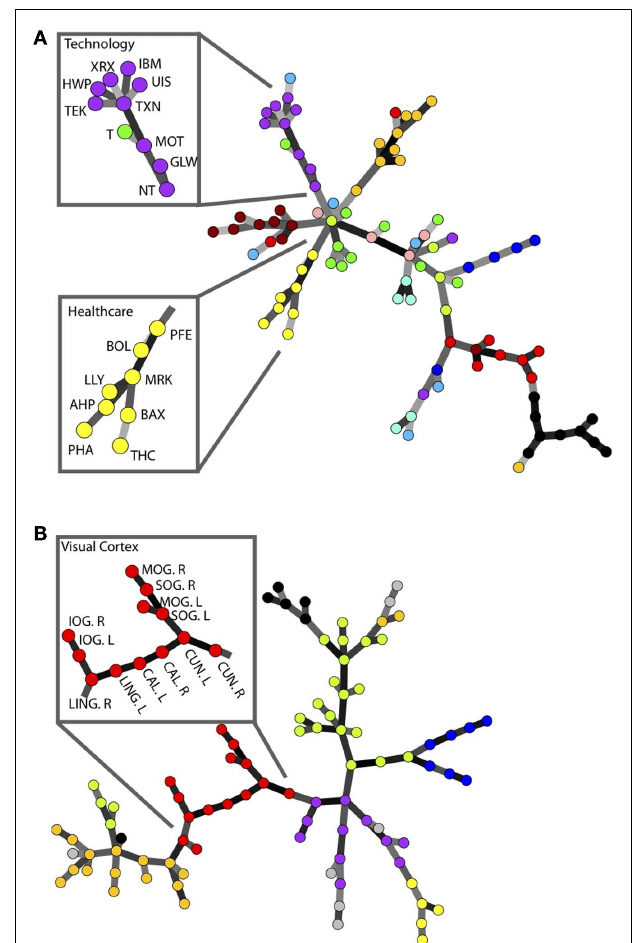
FIGURE 1 |A comparison of the modular structure of financial and brain functional networks. (A) MST for the daily closing prices of N = 90 NYSE-traded stocks from the time period from January 13, 1997 to January 29, 2000. Different colors denote various business sectors as defined in Forbes. Insets show the stock symbols of each node on the branches corresponding to the healthcare and technology sectors (Heimo, 2009). (B) MST for an fMRI-derived brain network with N = 90 regions. Modules identified in Meunier et al. (2009) are represented in different colors. Inset shows the name of each brain region on the branch corresponding to the visual